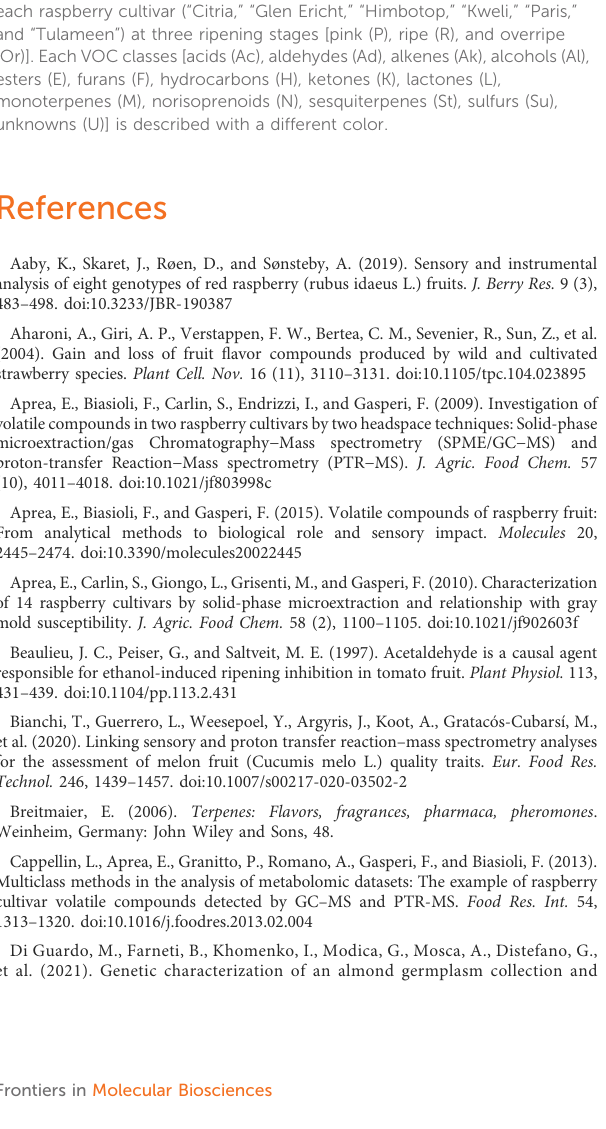
SUPPLEMENTARY FIGURE S2 Bar graph of the content of each VOC classes, expressed as μ g/Kg of 2- octanol, assessed by SPME-GC-MS for each raspberry cultivar ( “ Citria, ” “ GlenEricht, ”“ Himbotop, ”“ Kweli, ”“ Paris, ” and “ Tulameen ” )atthreeripening stages [pink (P), ripe (R), and overripe (Or)]. SUPPLEMENTARY FIGURE S3 Correlation plot of volatile organic compounds assessed by SPME/GC-MS. SUPPLEMENTARY FIGURE S4 Mass spectra of unknown compounds detected by SPME/GC-MS. SUPPLEMENTARY FIGURE S5 Bar graph of the content of each VOC, expressed as ppbv, assessed by PTR- ToF-MS for each raspberry cultivar ( “ Citria, ” “ Glen Ericht, ” “ Himbotop, ” “ Kweli, ” “ Paris, ” and “ Tulameen ” ) at three ripening stages [pink (P), ripe (R), and overripe (Or)]. Each value is the average plus standard deviation of three replicates. For each graph lines corresponding to the 25%, 50%, and 75% percentile were added. SUPPLEMENTARY FIGURE S6 Bar graph of the content of each VOC, expressed as ppbv, assessed by PTR- ToF-MS for each raspberry accession of the raspberry germplasm collection. Each value is the average plus standard deviation of three replicates. SUPPLEMENTARY FIGURE S7 Print screens of the Shiny web application (Qualysort 1.2; Farneti et al. 2020) with an examples of selected VOC traits (same compounds reported in Figure 6). This Shiny web application